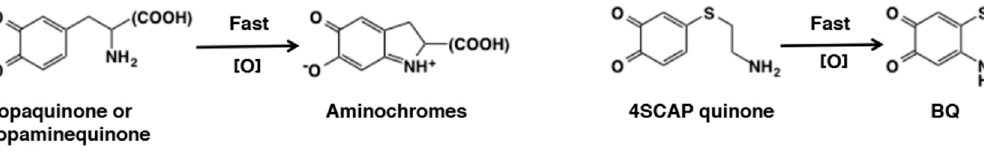
Figure 9. Intramolecular addition of amino group to o -quinone group to form aminochromes. A unique example of the intramolecular addition of amino group to form a six-membered ring is presented for 4SCAP quinone [50].